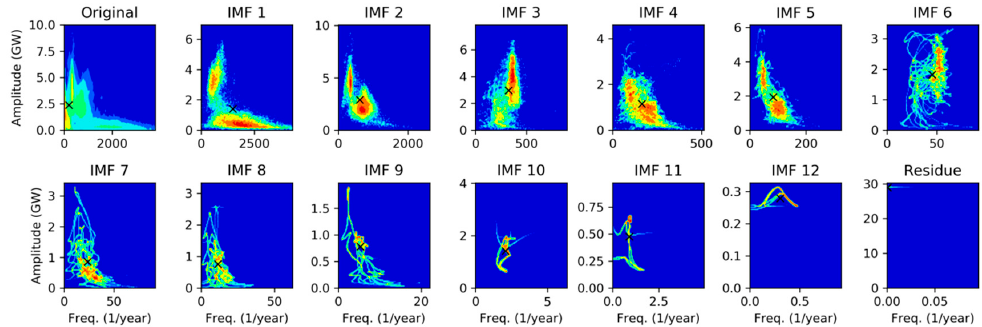
Figure 21. Joint Probability Density Function of the electricity demand IMFs Hilbert Spectra. Joint PDF values in log-scale and normalized in the 0–1 range.